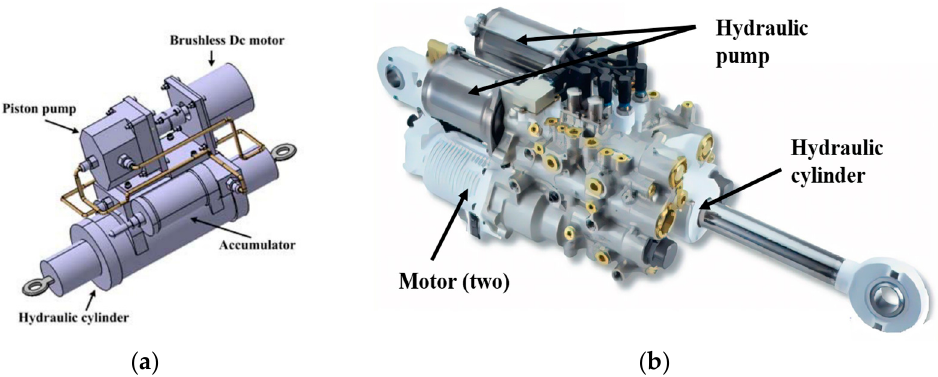
Figure 2. EHA with different redundancy. ( a ) Single redundancy EHA physical prototype [27]; ( b ) Double redundancy EHA physical prototype applied on F-35 [28].